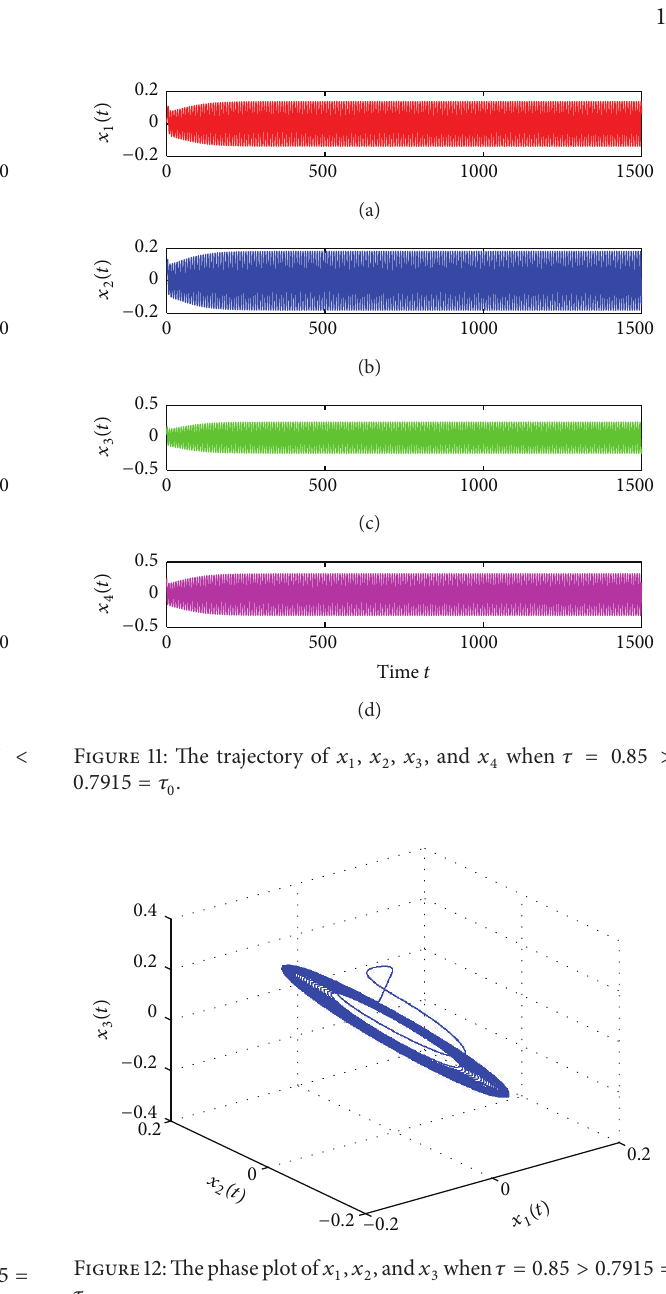
Figure 10: The phase plot of 𝑥 1 , 𝑥 2 , and 𝑥 3 when 𝜏 = 0.7 < 0.7915 = 𝜏 0 .